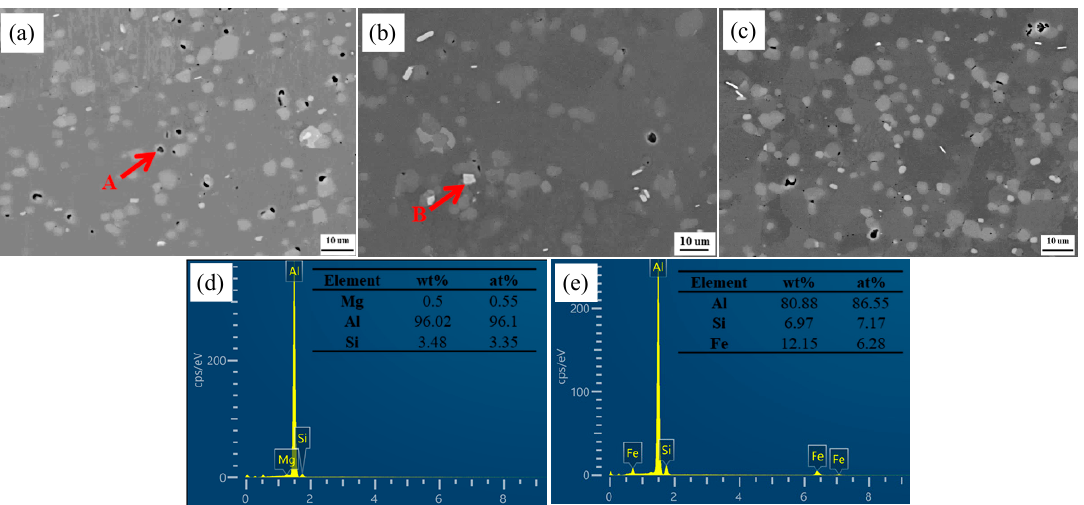
Figure 1. Optical micrographs under different states: ( a ) as ‐ cast; ( b ) T1; ( c ) T4; ( d ) T6.